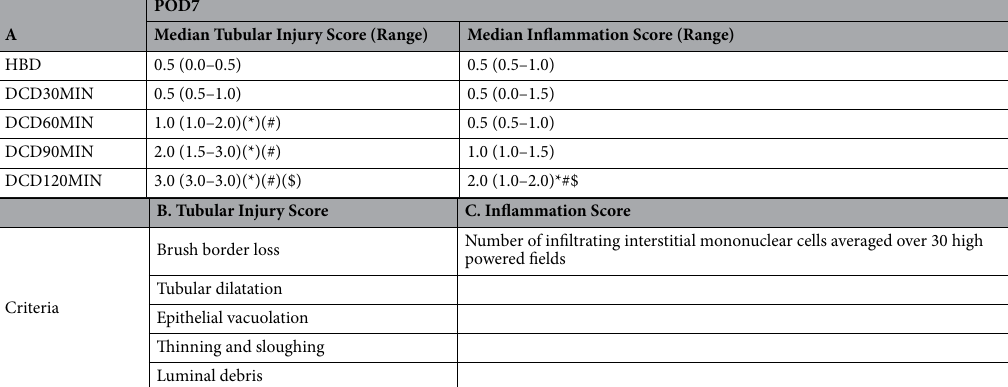
Table 1. Worsening histological tubular injury and inflammation with increasing warm ischemia. A Histological scores of tubular injury (0–3) and inflammation (0–3) assessed by a renal pathologist blinded to the groups. Scores taken at time of sacrifice on post-operative day 7 between all groups. Statistical difference p < 0.05 with $: HBD vs DCD60min, *:HBD vs DCD120min, #:DCD30min vs DCD120min, In brackets: p < 0.01. HBD Heart beating donor. DCD Donation after cardiac death. B Tubular injury and C inflammatory semiquantitative scores were determined using these